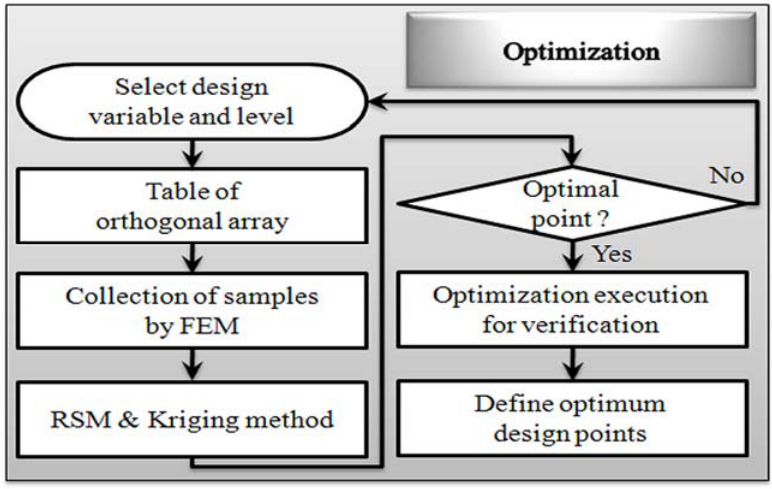
Figure 2. Optimization flow chart.